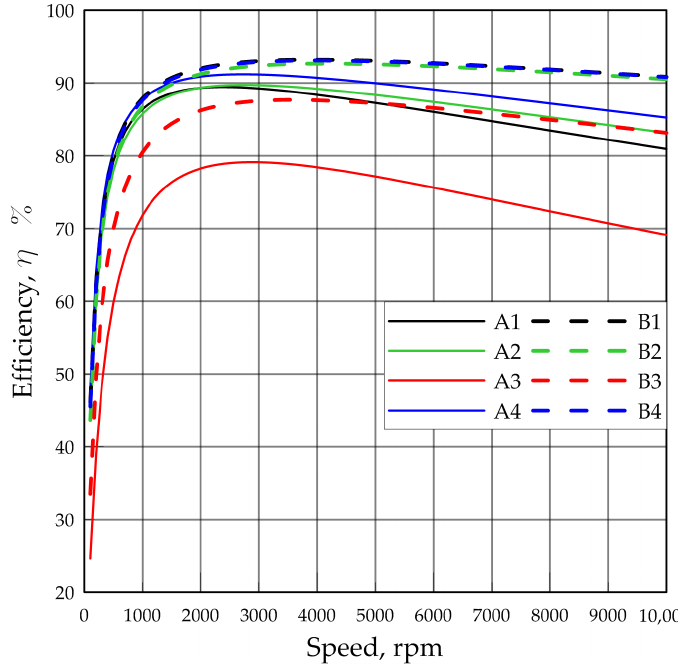
Figure 10. Efficiency over wide range of speeds.